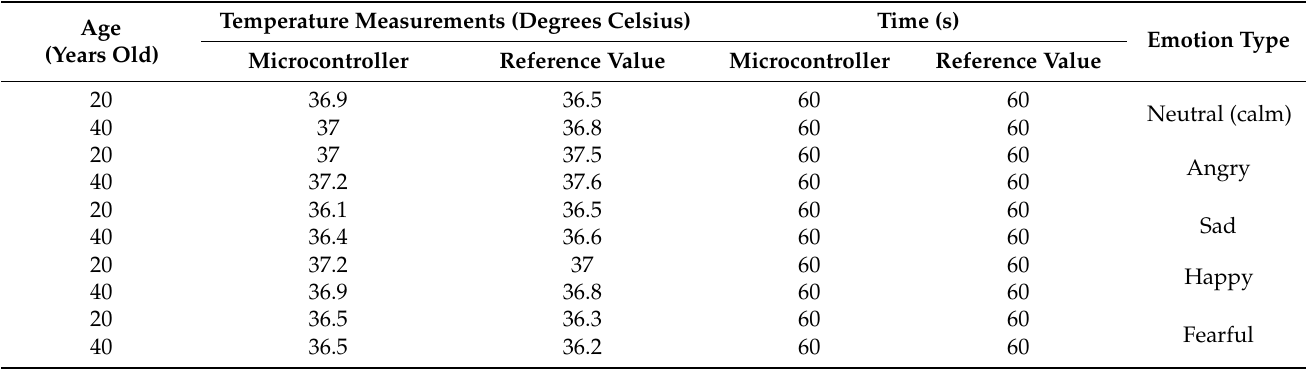
Table 3. Average Body Temperature